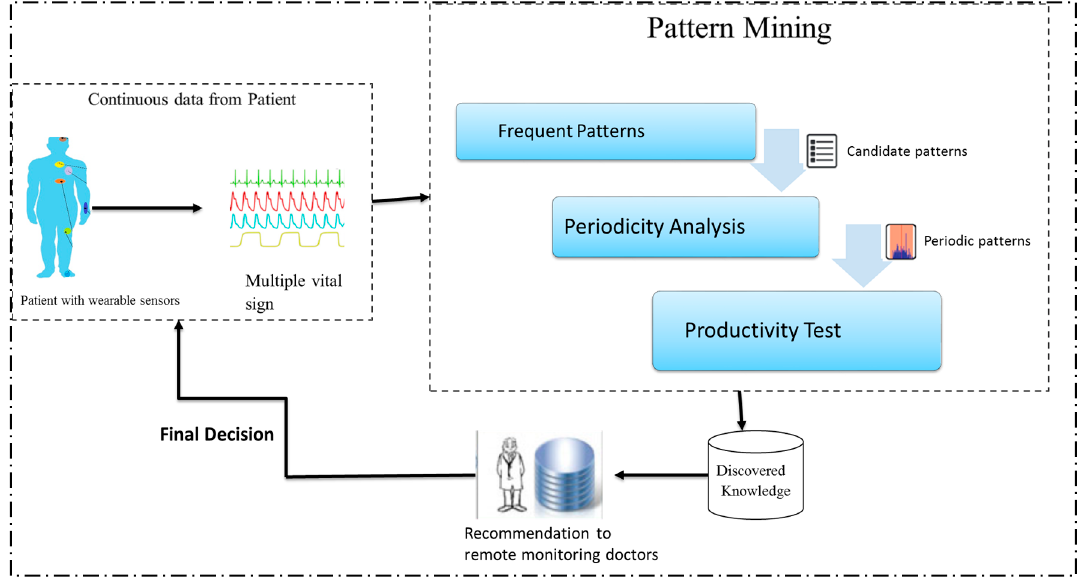
Figure 1. The workflow of productive-associated periodic-frequent pattern mining.